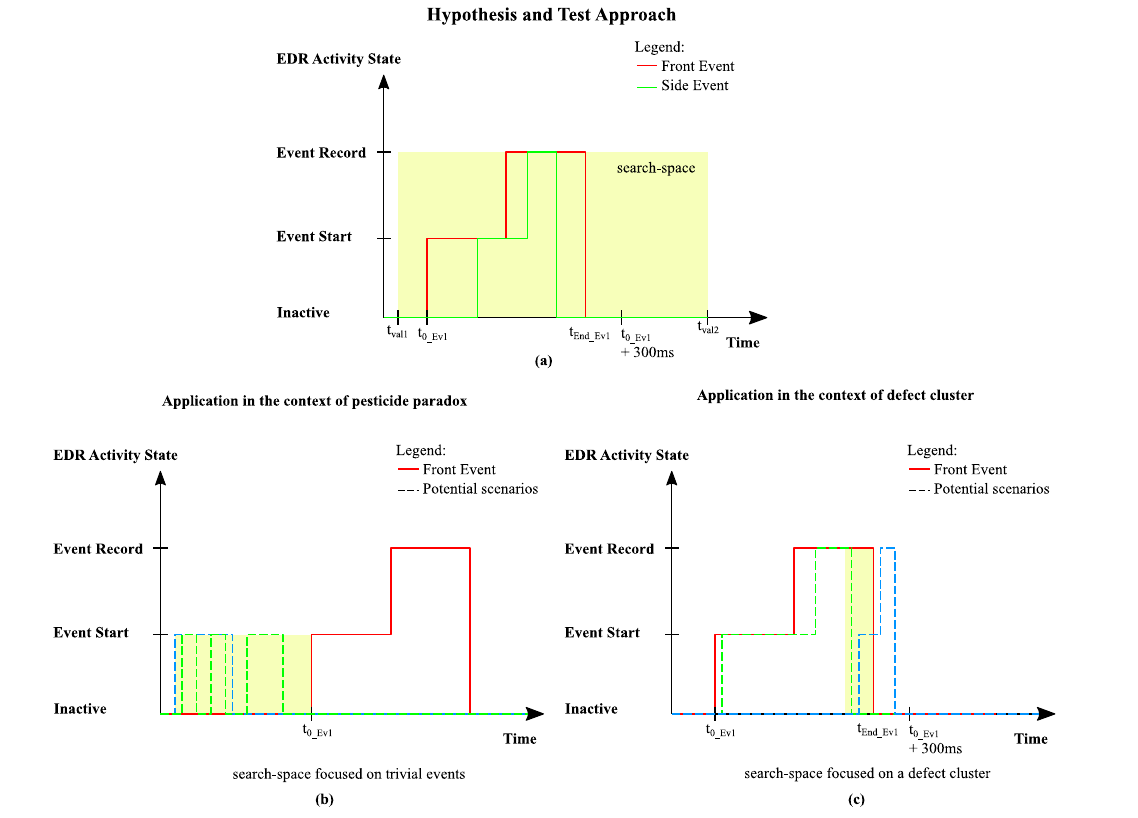
Figure 10. Overview hypothesis and test approach. ( a ) search-space definition within the hypothesis; ( b ) application of